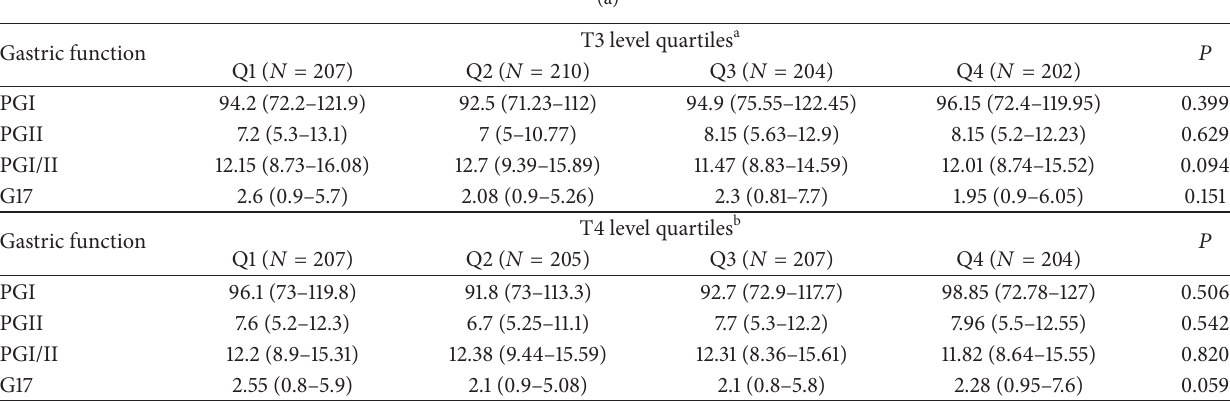
Table 4: (a) The correlation between gastric function indicators and T3 and T4 levels in serum. (b) The correlation between gastric function parameters and TSH, TPOAb, and TGAb levels in